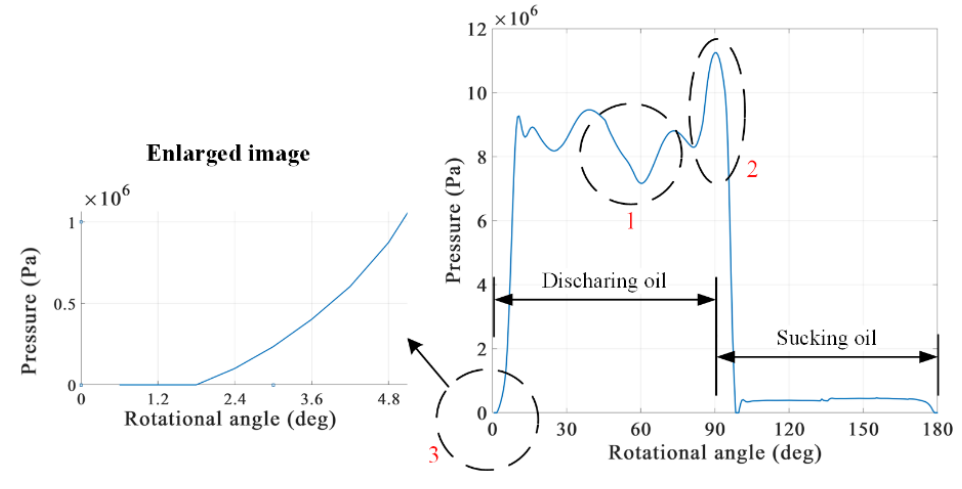
Figure 11. The chamber pressure in the LLC.